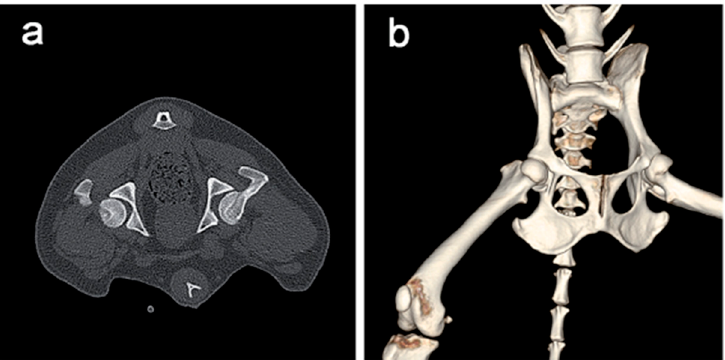
Figure 3. CT scan image. ( a ) CT scan images before segmentation; ( b ) three-dimensional (3D) reconstruct from CT scan [47].